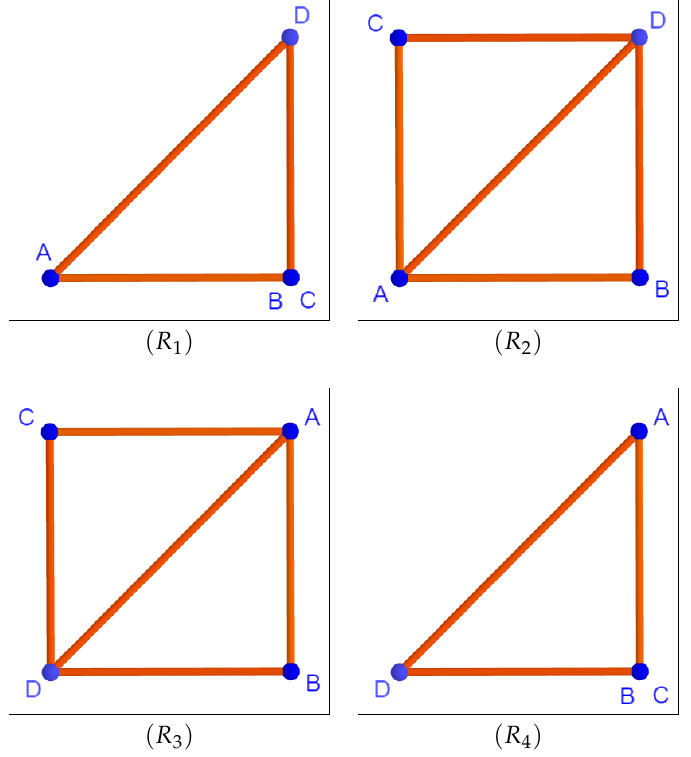
Figure 8. Realizations for V 2 ( PD ( i )) for i =